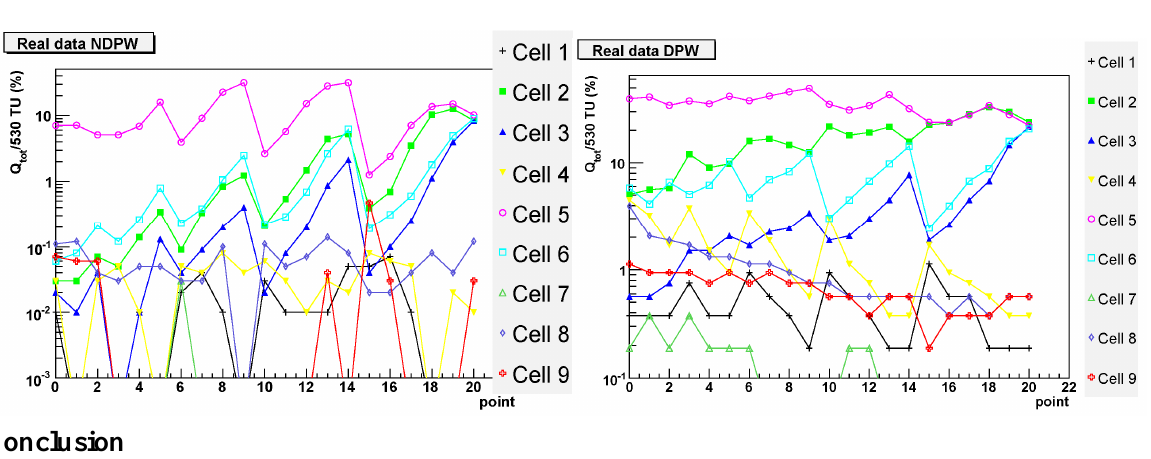
Figure 10. Experimental results corresponding to the simulation shown in Figure 8. On the left: without deep P-well. On the right: with deep